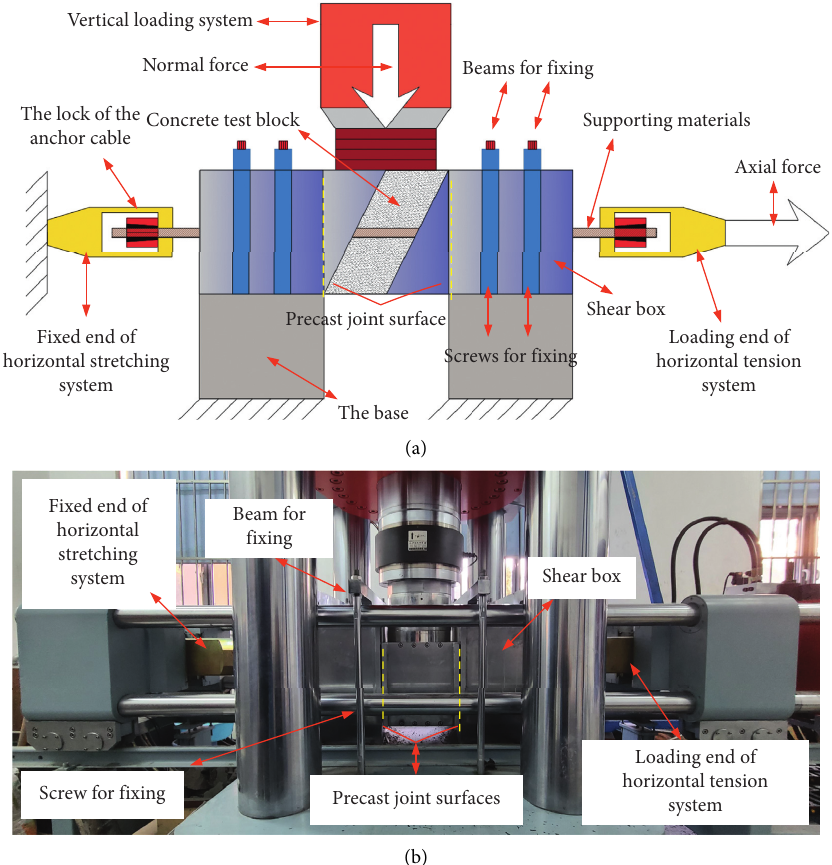
Figure 2: Sketch map of tension and shear system of Anchor Cable (bolt) and C-shaped Tube. (a) Diagram of instrument. (b) Physical drawing of the instrument.